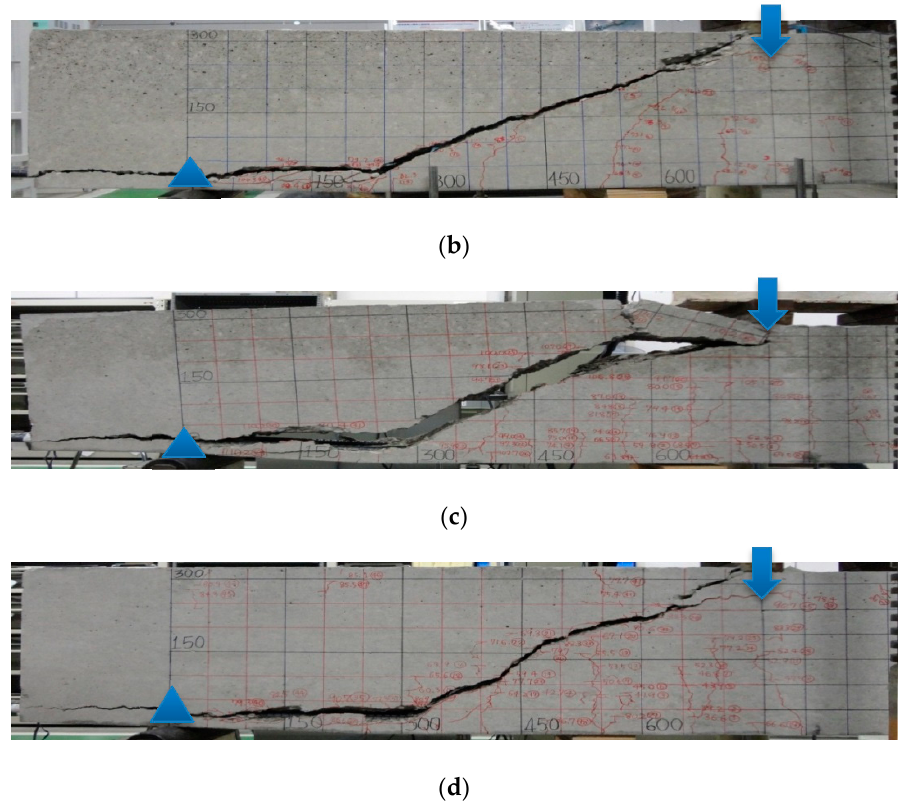
Figure 16. Failure mode of the large reinforced concrete (RC) beams. ( a ) Beam NB60; ( b ) beam HB60; ( c ) beam MB60; and ( d ) beam LB60.